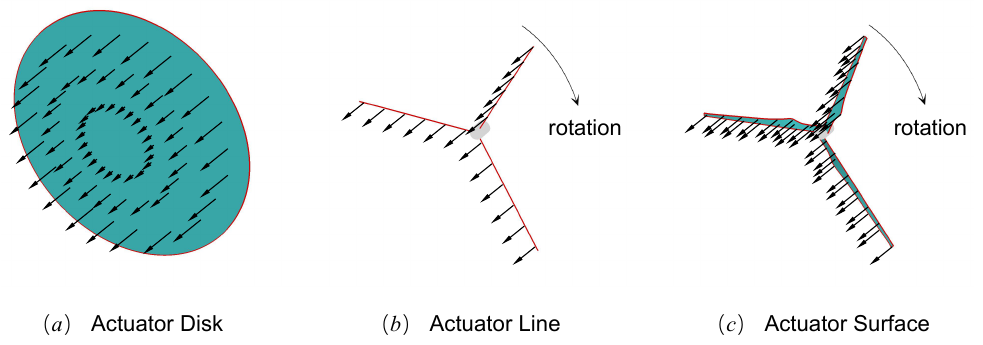
Figure 1. Wind turbine rotor parameterization models for wake simulations with computational fluid dynamics approaches. ( a ) AD model: the rotor is simplified as a thin round disk of the same size as the rotor-swept area; ( b ) AL model: the blades are simplified as lines; ( c ) AS model: the blades are simplified with zero thickness surfaces defined by the blade’s chord and twist